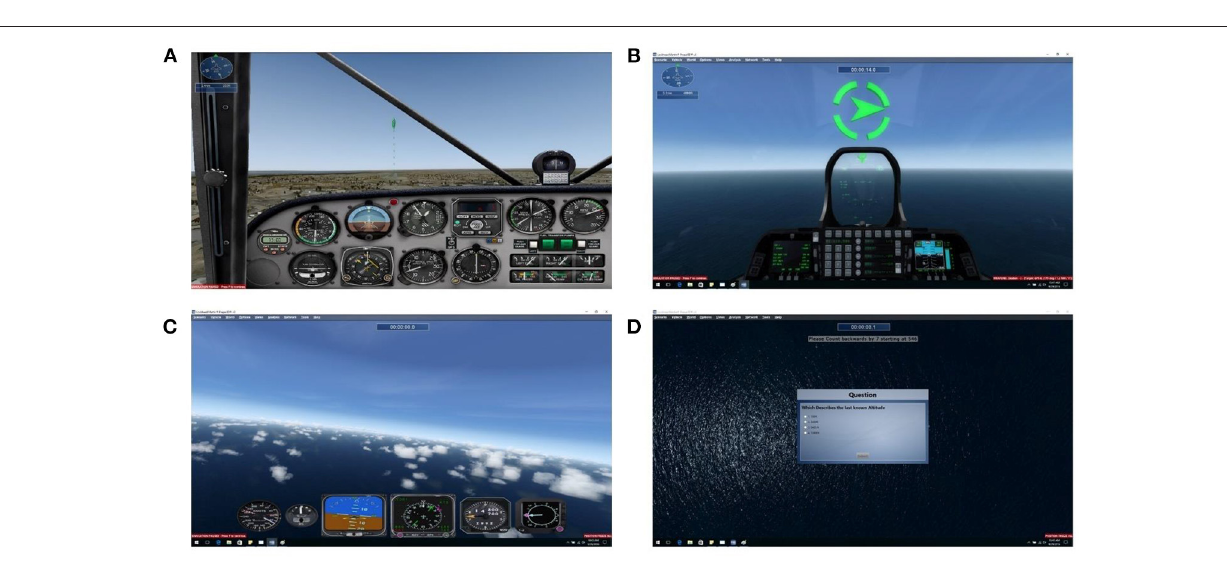
control to roll only and have set autopilot for speed and